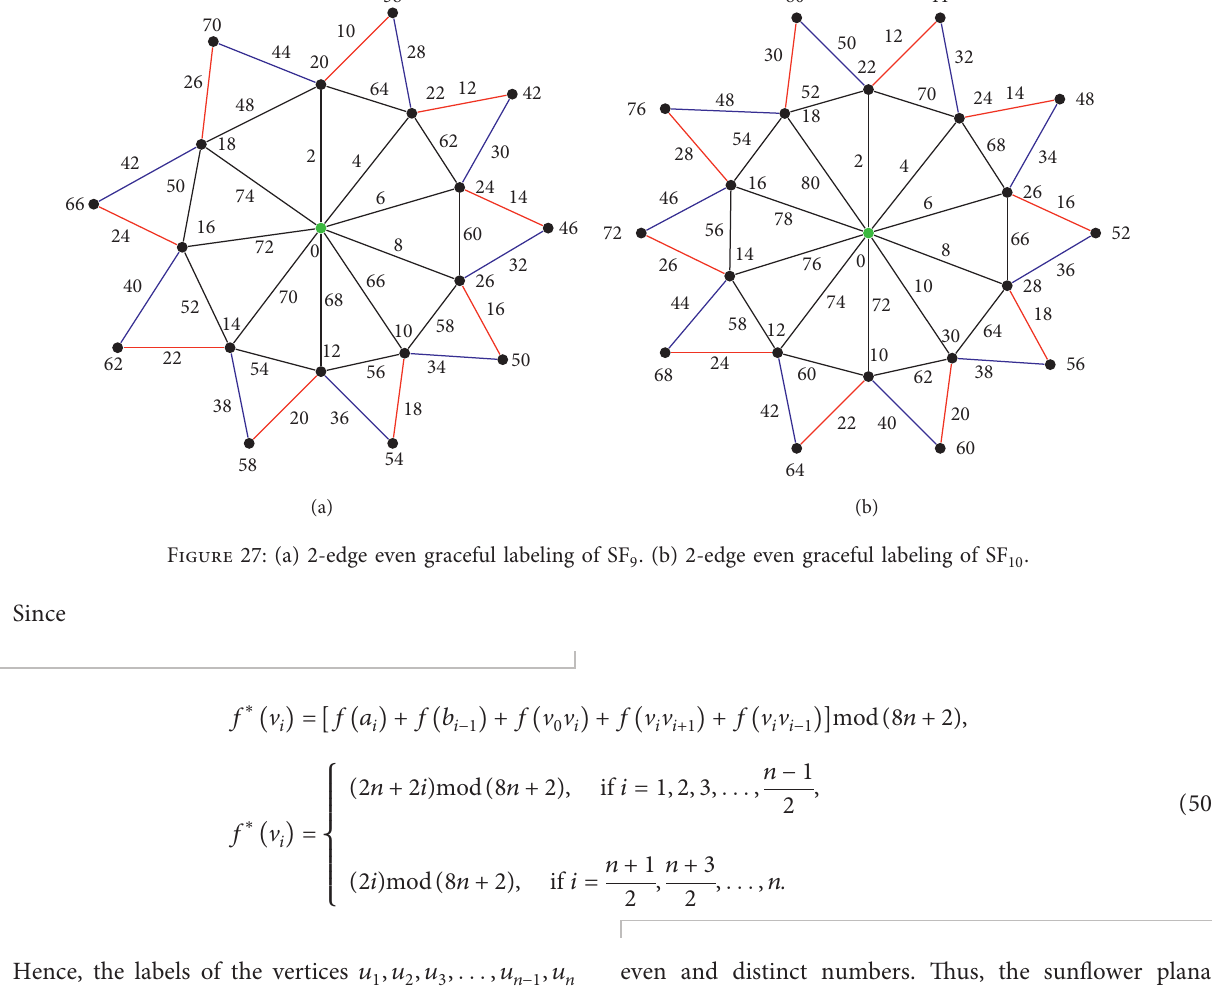
n with ordinary labeling.